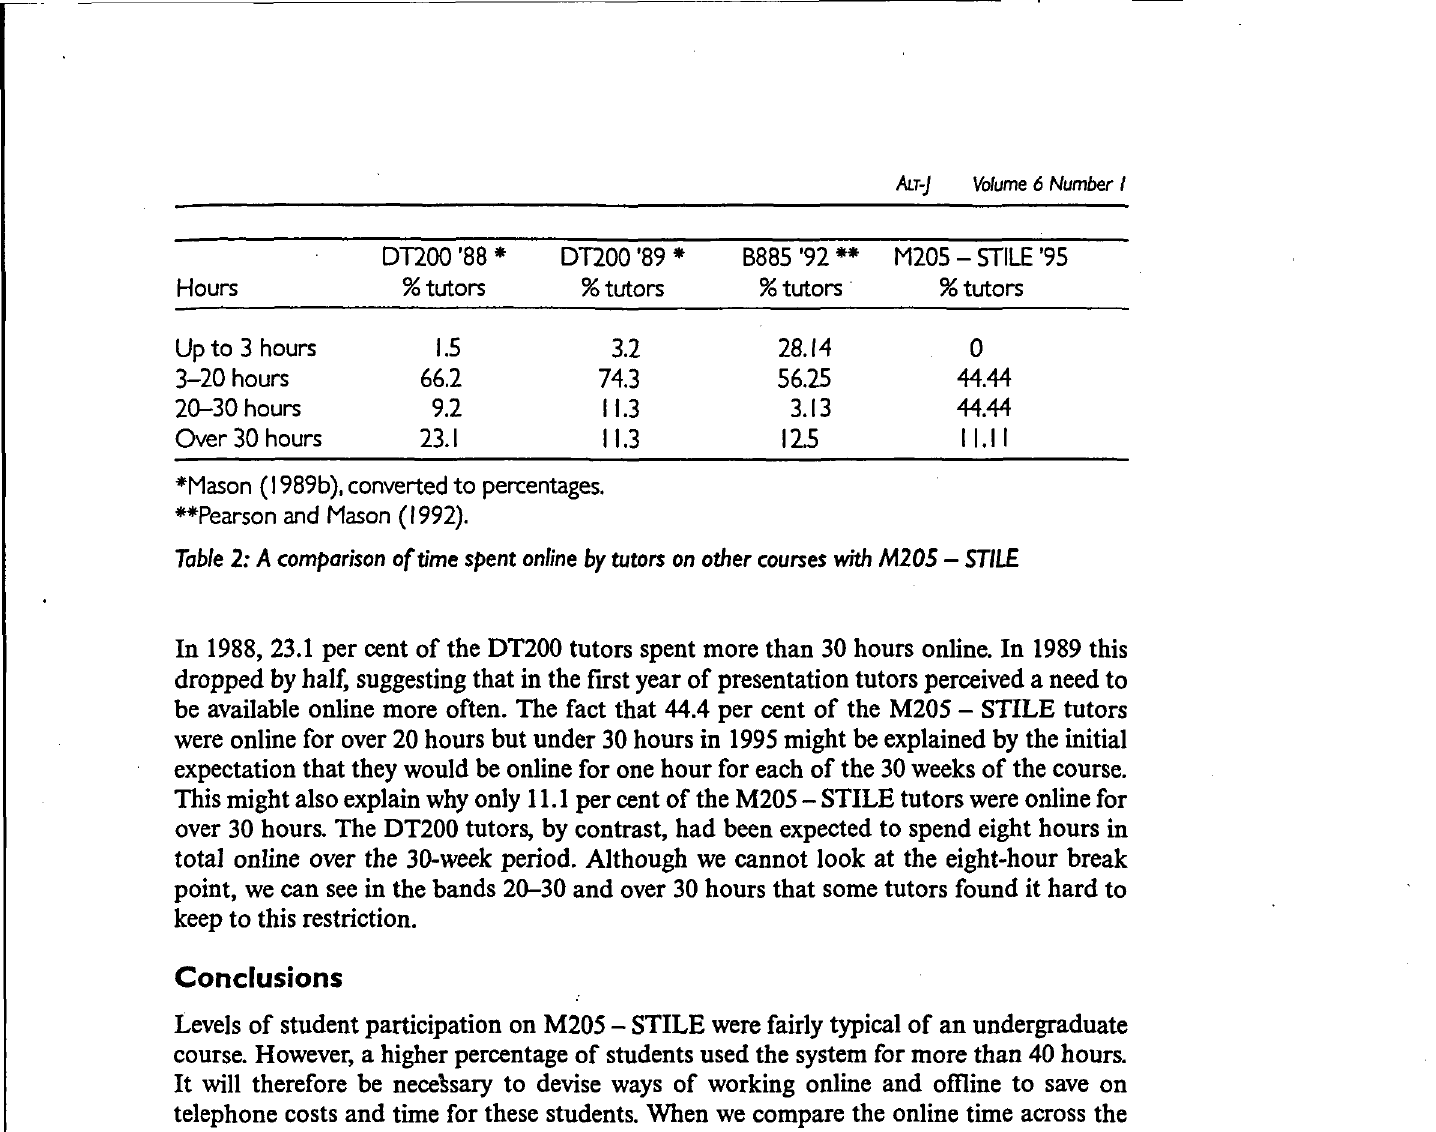
Table 2: A comparison of time spent online by tutors on other courses with M205 - STILE